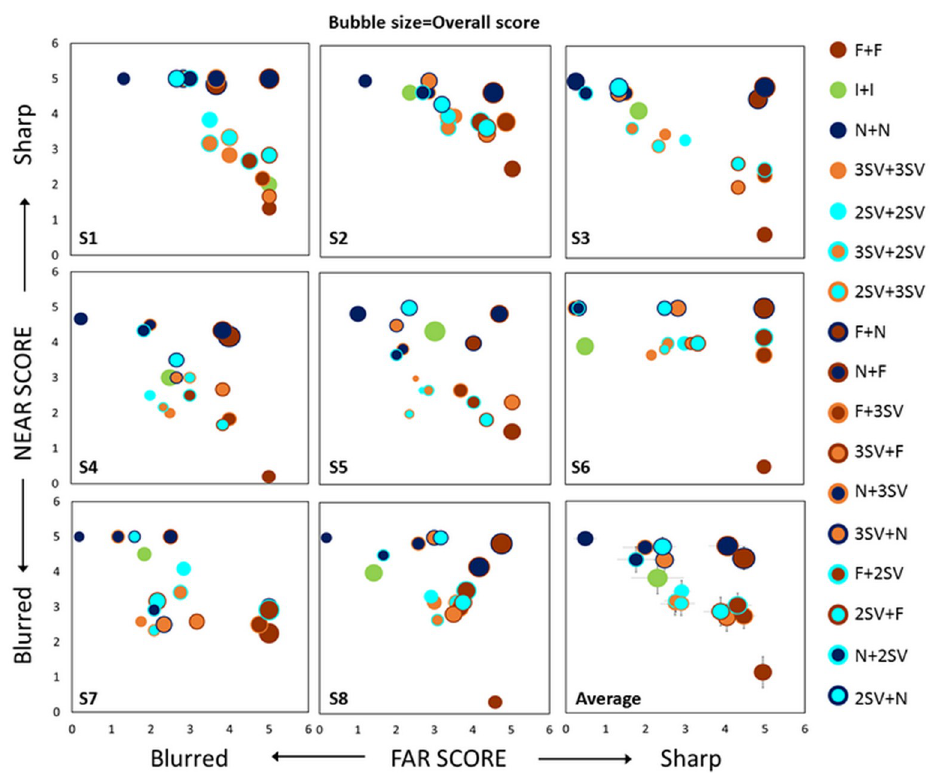
Fig 4. Binocular perceptual score for far (x-axis), near (y-axis) and overall (bubble size) for individual subjects (S1 to S8) and on average across subjects. The error bars (lower right box) represent the average PS variation across repetitions, averaged across subjects. They therefore show intersubject consistency in the scores, and not dispersion across subjects.